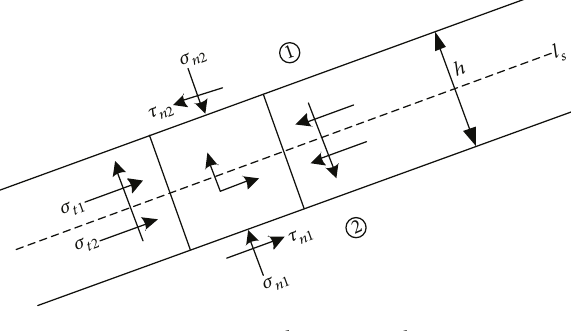
Figure 5: Stress discontinuity